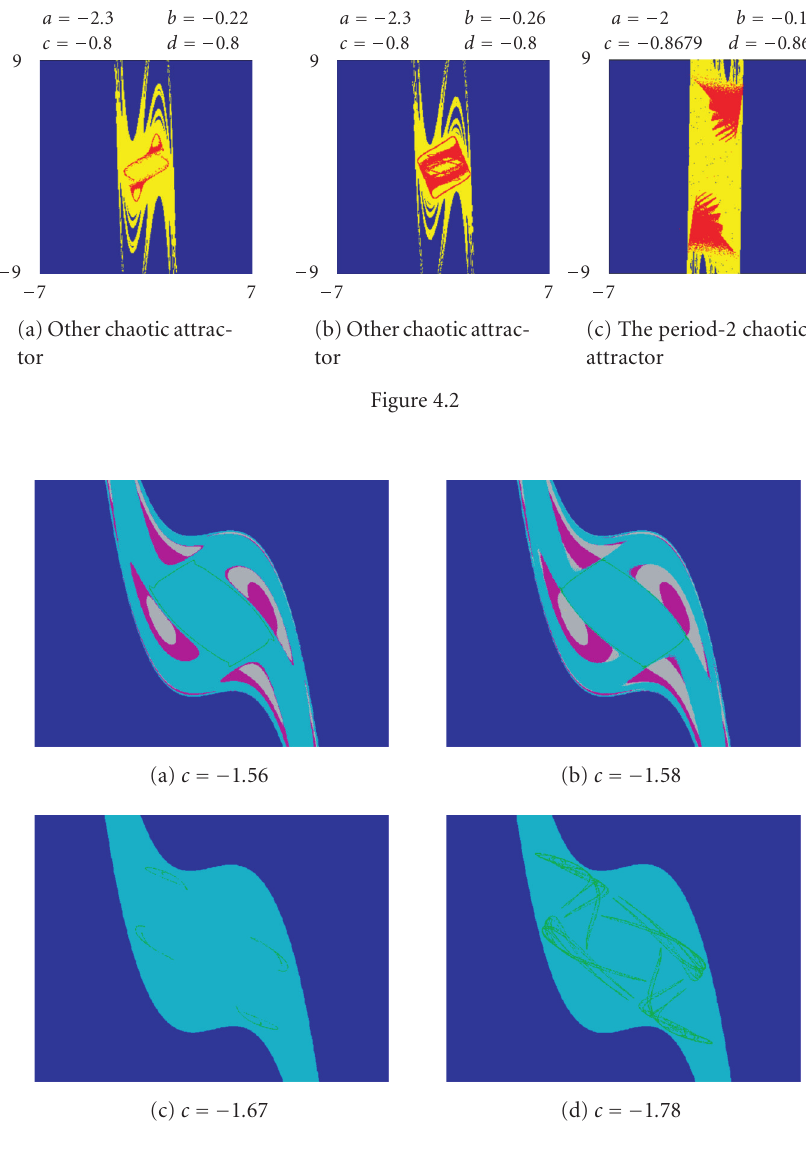
Figure 4.3. (a) The colors correspond to the basins of the two existing attractors: the invariant closed curve and a 4-periodic orbit. (b) The closed curve grows in size (c) and (d) for c = − 1 . 67 to − 1 . 78 the period-4 chaotic attractor near the boundary